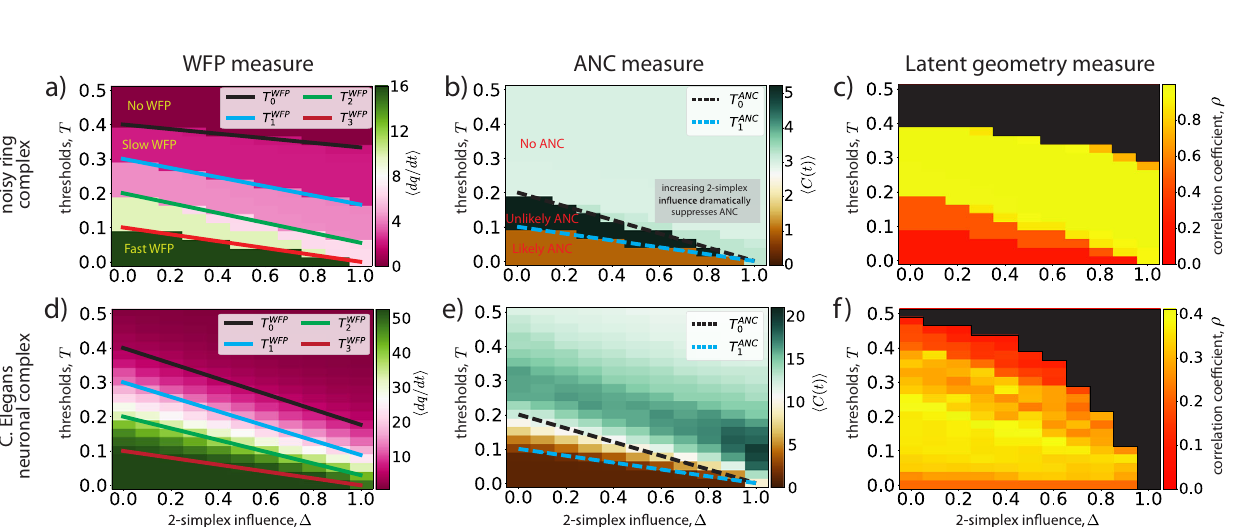
Fig. 5 Bifurcation theory characterizes wavefront propagation and appearance of new clusters over K -dimensional geometrical channels. We consider 2D simplicial threshold model (STM) cascades over a noisy ring complex (recall Fig. 2b) for various T and either (left) Δ = 0.1, (center) Δ = 0.5, or (right) Δ = 0.9. a Bifurcation diagrams depict the critical thresholds T WFP and T ANC given by Eqs. (3) and (4), respectively, for different T , d ( NG ) and d ( G ) . We fi nd 0 0 four regimes that are characterized by the absence/presence of wavefront propagation (WFP) and appearance of new clusters (ANC). Observe that increasing Δ suppresses ANC, and the regime that exhibits ANC with no WFP disappears under higher-order interactions with Δ > 0.1. Vertical gray lines and horizontal colored marks identify the values d ( NG ) / d ( G ) = 0.25 and T ∈ {0.05, 0.1, 0.275, 0.35, 0.5}, and in panels b and c , we show for these values that the spatio-temporal patterns of STM cascades are as predicted. b Colored curves indicate the sizes q ( t ) of STM cascades versus time t , averaged across all possible initial conditions with cluster seeding. c Colored curves indicate the average number C ( t ) of cascade clusters, and one can observe a peak only when ANC occurs. Three scenarios give rise to WFP and ANC: ( Δ , T ) ∈ {(0.1, 0.05), (0.1, 0.1), (0.5, 0.05)}. Four scenarios give rise to no spreading: ( Δ , T ) ∈ {(0.1, 0.5), (0.5, 0.5), (0.9, 0.35), (0.9, 0.5)}. The other selected values of Δ and T yield WFP and no ANC, in which case q ( t ) grows